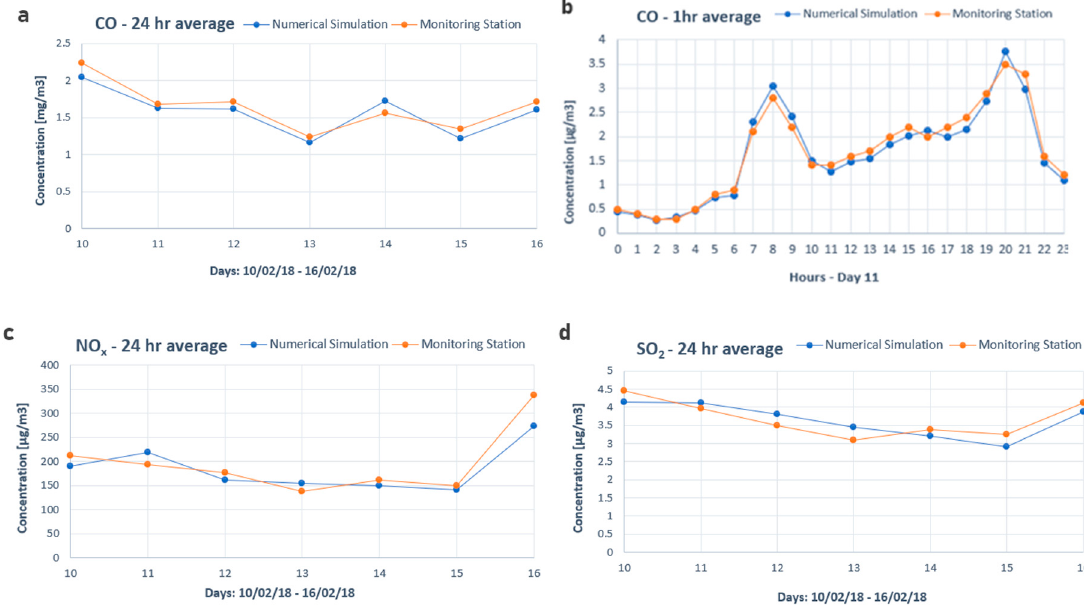
Figure 5. Timeseries of measurements (orange) [73] and present calculations (blue) for ( a ) 24 h and ( b ) 1 h average of CO concentration and 24 h average of ( c ) NO x and ( d ) SO 2 at Patision Station (Figure 4).